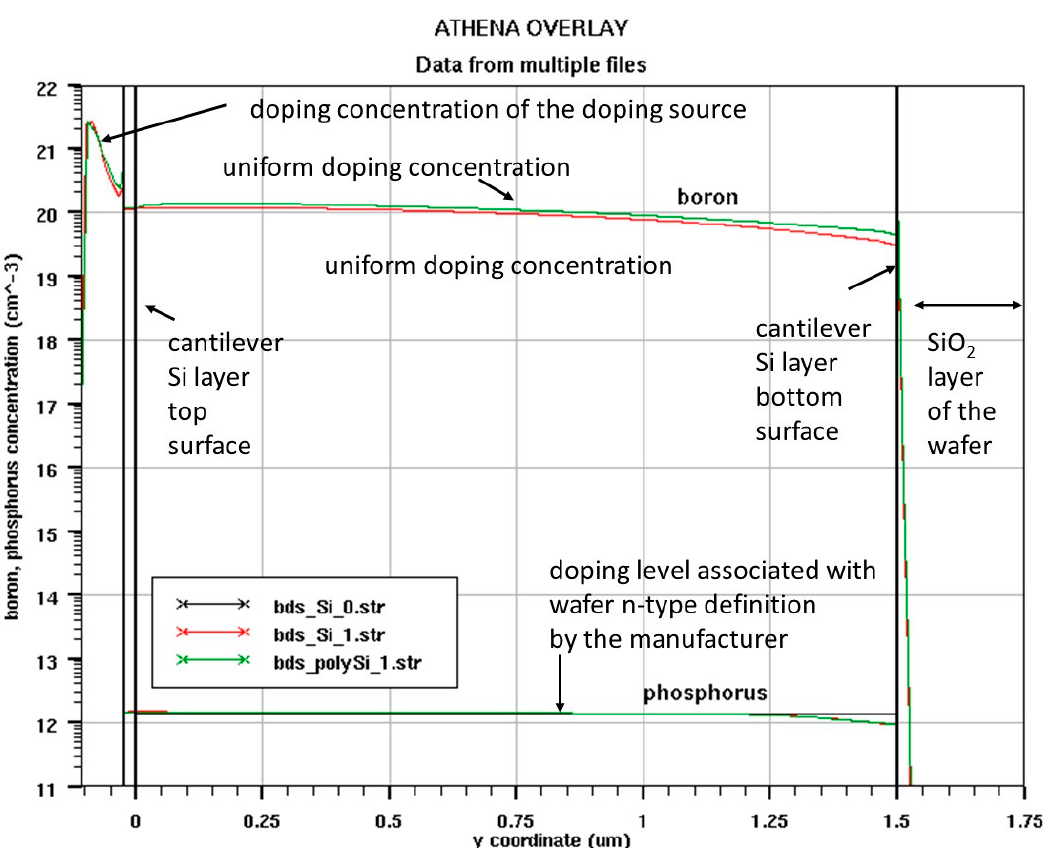
Figure 4. The high concentration of p dopant layer simulation result for the silicon on insulator (SOI) cantilever. Red and green curves represent two methods of doping concentration calculation.